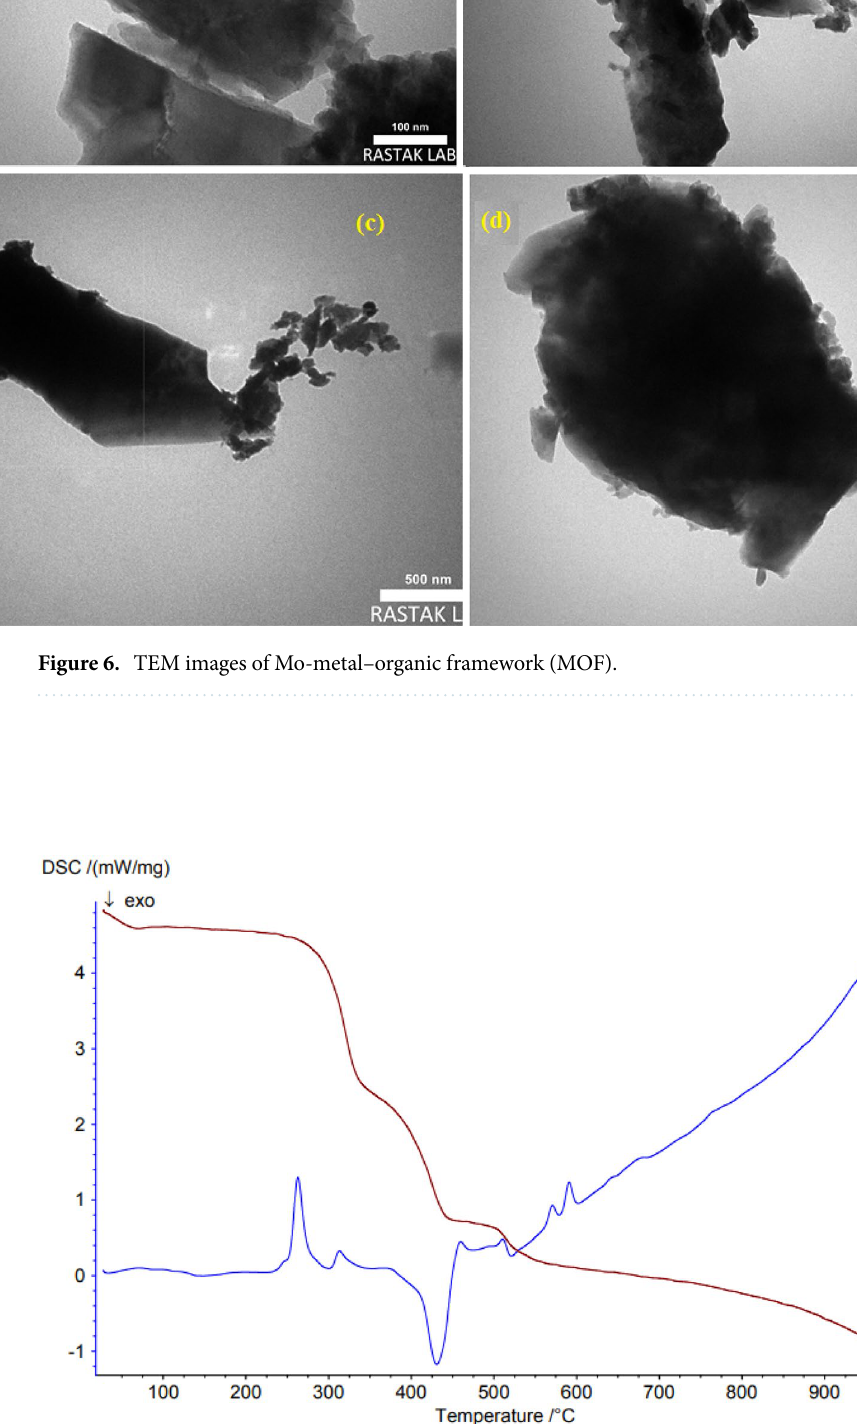
Figure 7. TGA of Mo-metal–organic framework